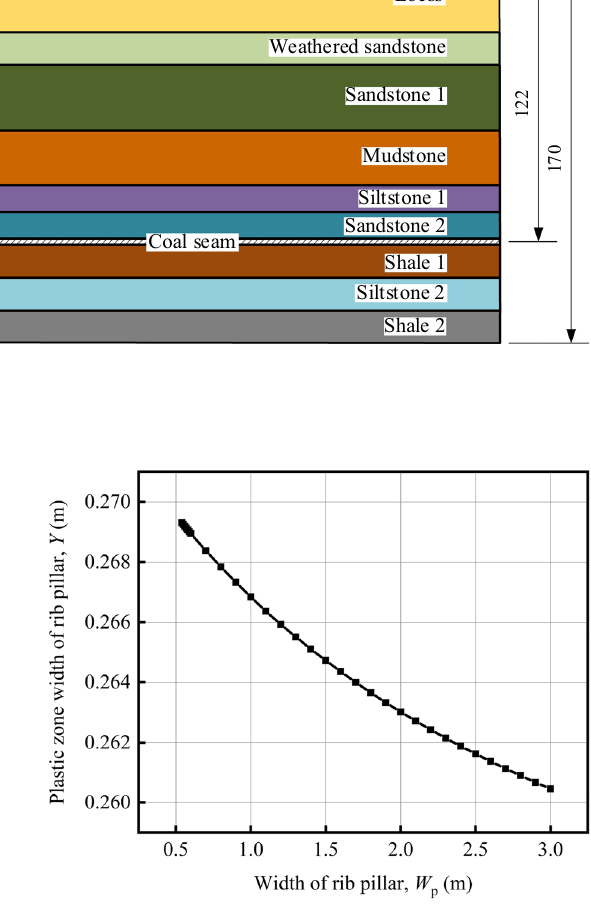
Fig. 10 Plastic zone width of the rib pillar with different pillar widths beneath the No. 1 haulage